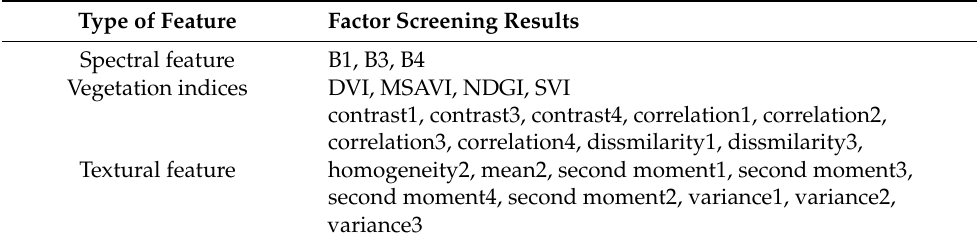
Table 5. Factor screening results.